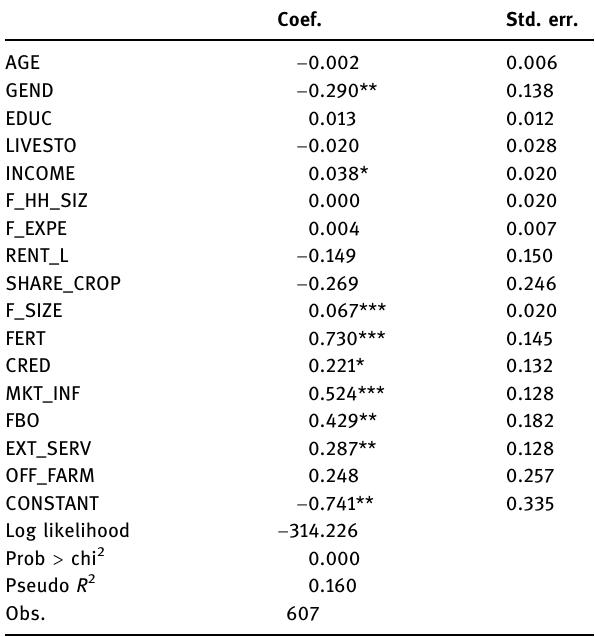
Table 5: Probit estimation results of improved rice variety adoption ( PSM ) Coef. Std.